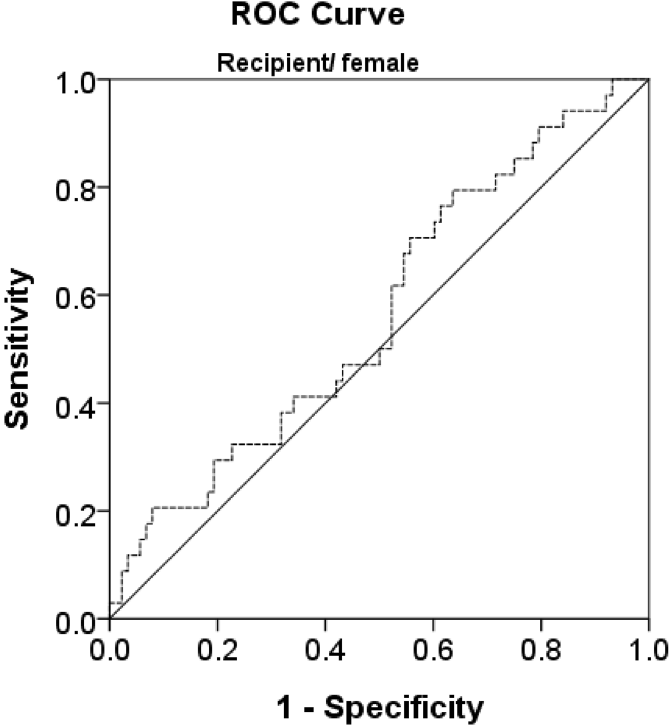
Figure 1. ROC curve analysis revealed PMI correlation with major complications after living donor liver transplant(P = 0.028). The PMI cut-off point as 2.63 (sensitivity = 20.6%, specificity = 92%, AUE = 0.567).